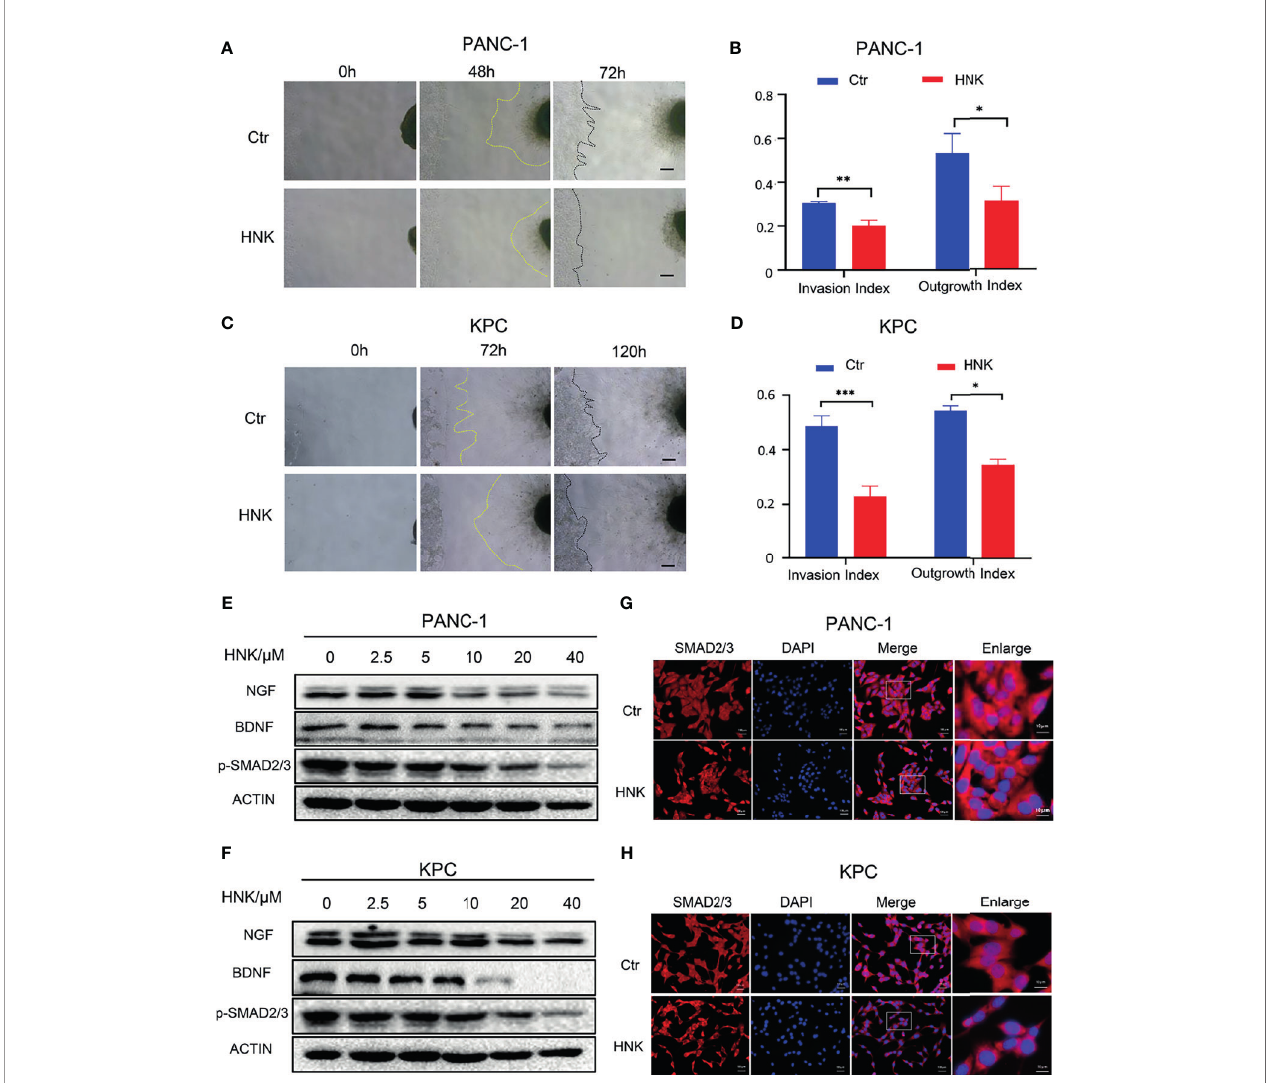
FIGURE 2 | HNK suppresses perineural invasion and SMAD2/3 signaling in pancreatic cancer. (A, B) Cancer cell-DRG coculture model of the control group and HNK group in PANC-1 cells, scale bar = 200 m m; (C, D) Cancer cell-DRG coculture model of the control group and HNK group in KPC cells, scale bar = 200 m m; (E) Western blotting analysis of the expression of NGF, BDNF, and p-SMAD2/3 in PANC-1 cells; (F) Western blotting analysis of the expression of NGF, BDNF, and p-SMAD2/3 in KPC cells; (G, H) Immuno fl uorescence staining SMAD2/3 on PANC-1 and KPC cell lines. * p < 0.05, ** p < 0.01, *** p <